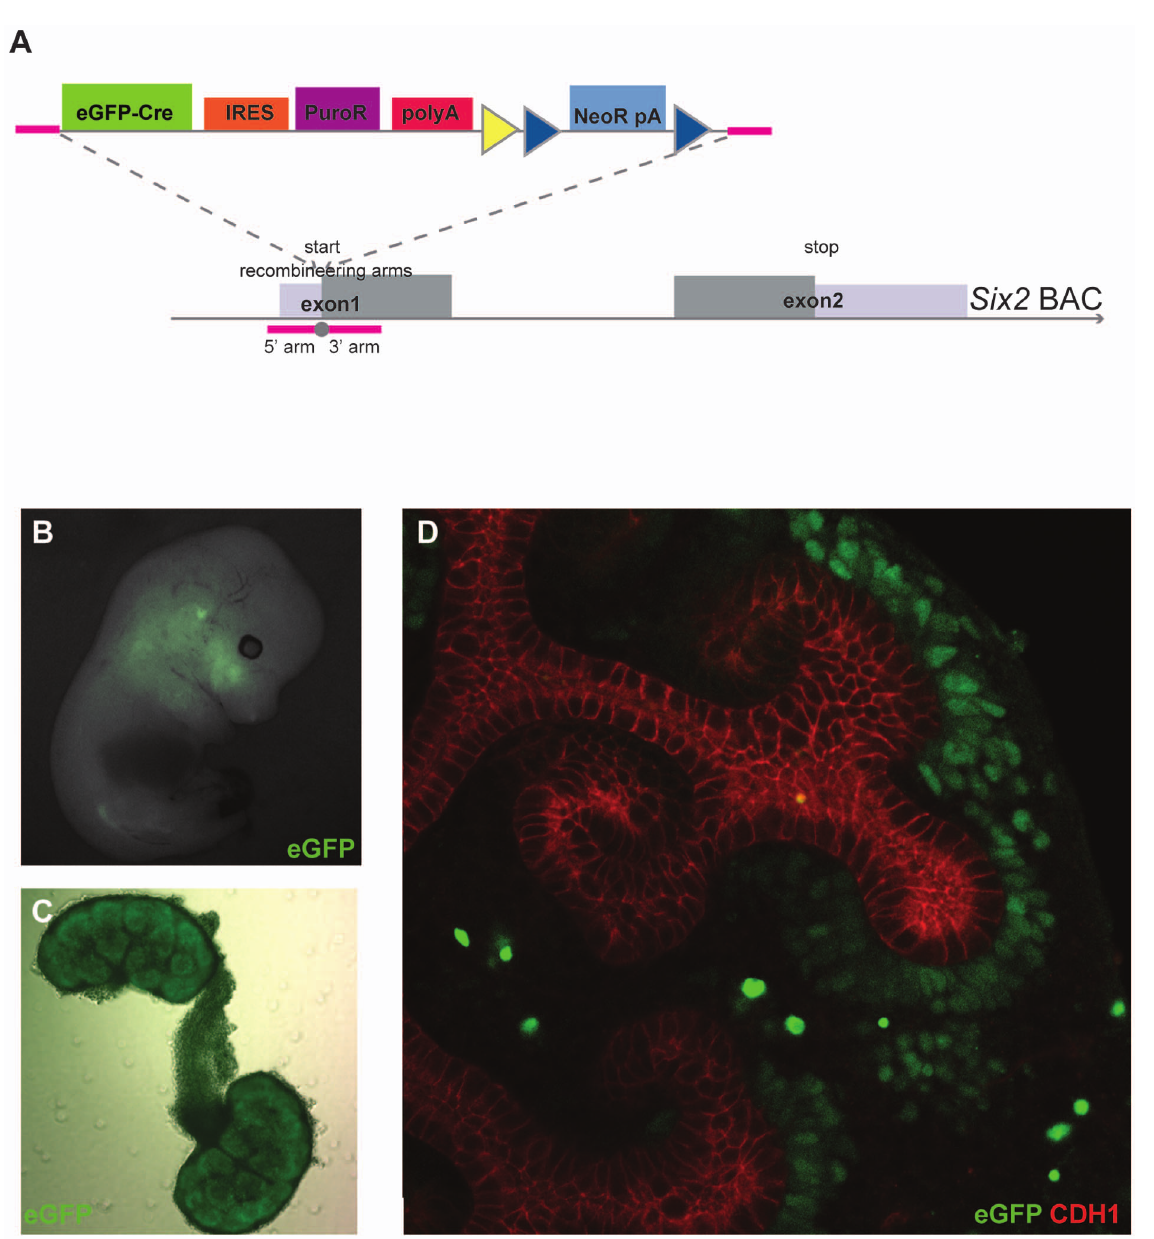
Figure 3. The Six2 -GCiP BAC construct made using pMULTIrec. A. The four-fragment and dual selection cassette from pMULTIrec was cloned in a Six2 containing BAC replacing the start codon. B. GFP imaging of a E13.5 embryo carrying the Six2 -GCiP BAC. C. GFP imaging of whole mount E13.5 kidneys. D. E13.5 Six2 -GCiP BAC kidneys cultured for four days showing GFP expression in the cap mesenchyme and Cdh1 expression in the ureteric